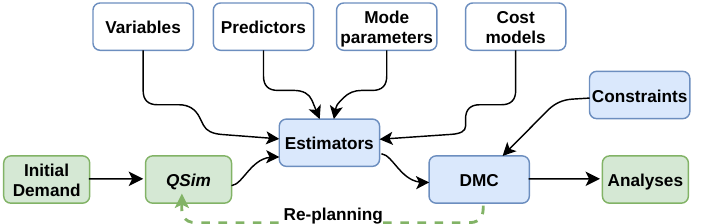
Figure 2. Simulation cycle for MATSim and eqasim - Adapted with permission from ref.